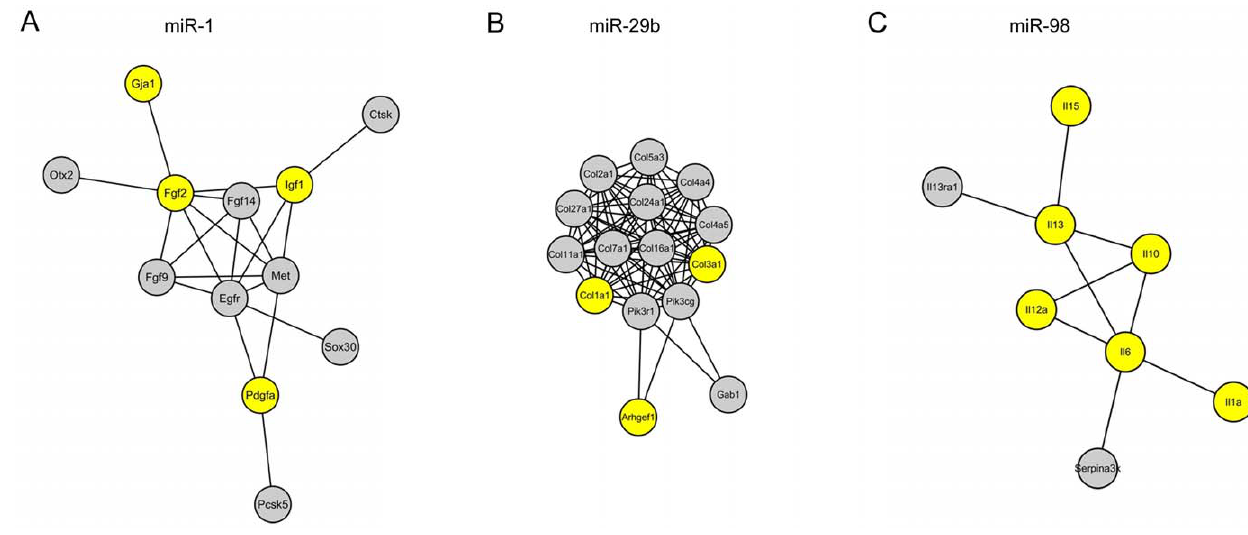
Figure 3. Results of ClusterOne analysis. A-C. Largest functional modules regulated by miR-1, miR-29b and miR-98, respectively. The yellow nodes represent proteins encoded by genes that are associated with ischemia. (Figure 3). The result demonstrated that miR-1 stressed upon regulation of myocyte growth, yet miR-29b and miR-98 put their regulatory emphases upon fibrosis and inflammation, respectively.